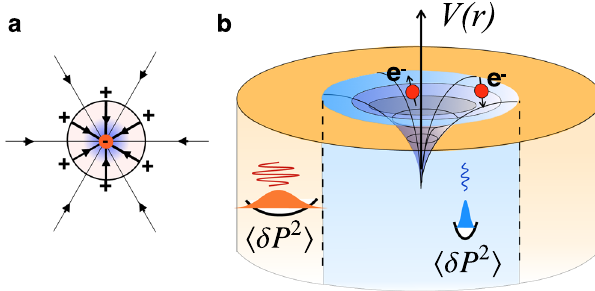
Fig. 1 | Interactions between electrons in a quantum critical polar metal. a the electric lines of force around an electron are ionically screened, b the fl uctuations of the phonon energy density around electrons (see Eq. (1)) create an attractive potential